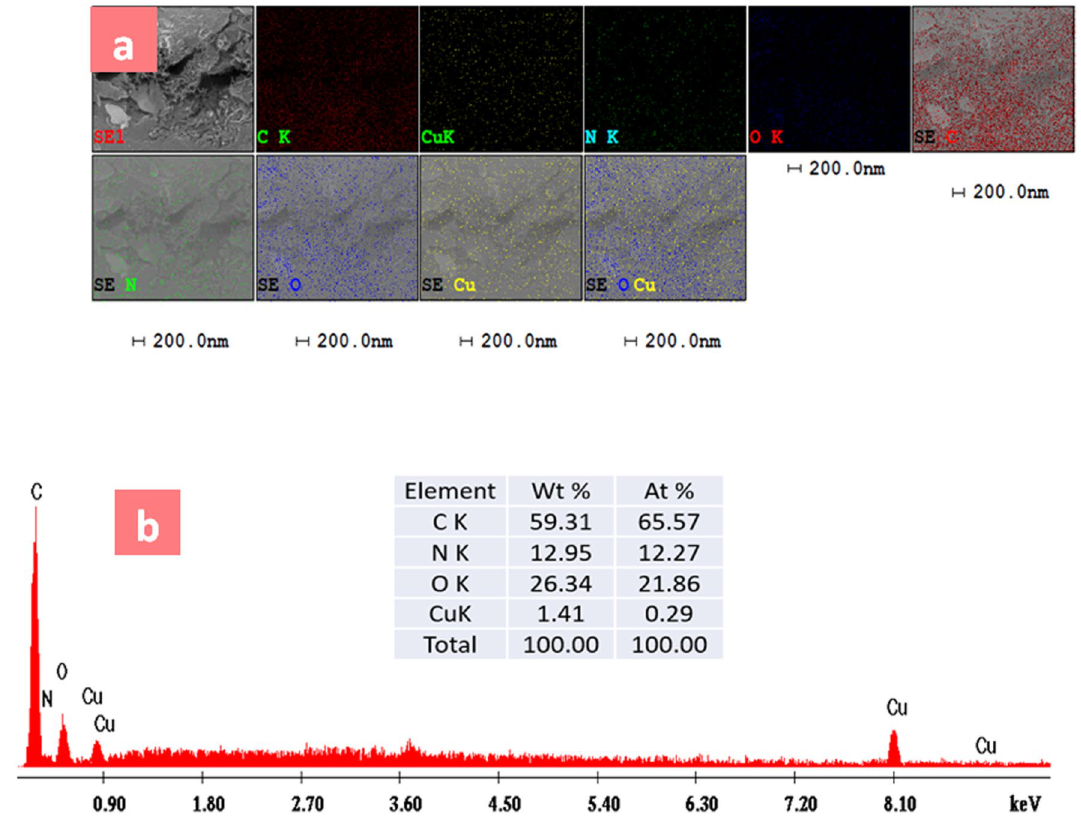
Figure 2. EDX ( a ) and maps analyzes ( b ) of CPA/N-SWCNTs-GO-CE/CuO nanocomposites.